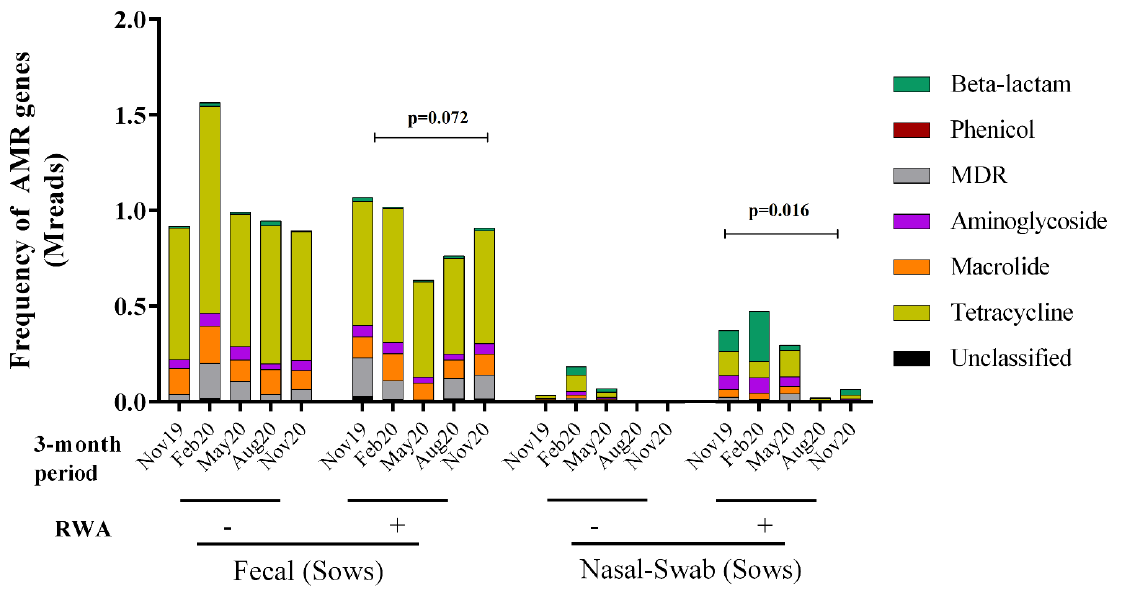
Figure 3. Metagenomic resistome showing the frequency of antibiotic resistance genes (ARGs) clustered into six classes: tetracycline, aminoglycoside, macrolide, phenicol, β -lactam, and multi-drug resistance (MDR) and collected from sow feces and nasal swab samples in non-RWA − (minus sign) and RWA + (plus sign) barns. Two data sets from each type of barn (non-RWA and RWA) were included as biological replicates for PERMANOVA analysis of the non-RWA vs. RWA resistome profiles. The ARG frequency in sow feces in RWA barns was not significantly different ( p = 0.072) from non-RWA barns (Figures 3 and 4A). The ARG frequency in samples collected from sow nasopharynx was significantly higher ( p = 0.016) in RWA barns compared to non-RWA barns.